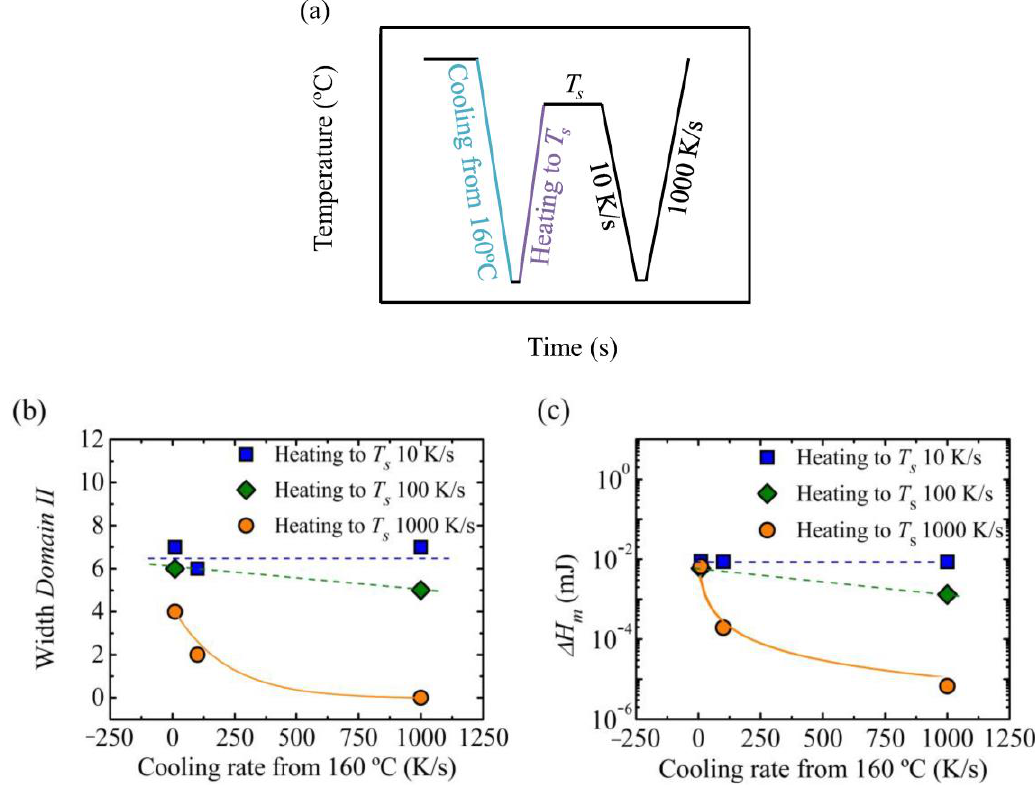
Figure 7. ( a ) Thermal procedure employed to analyze the effect of cooling rate from 160 °C and heating to T s , in order to erase the thermal history the sample is kept at 160 °C for 30 s and it is cooled down to −50 °C, the sample is kept at this temperature, −50 °C, for 0.1 s, the sample was kept at the T s temperature for 300 s, ( b ) width of Domain II as a function of the cooling rate from 160 °C and ( c ) melting enthalpy as a function of the cooling rate from 160 °C.